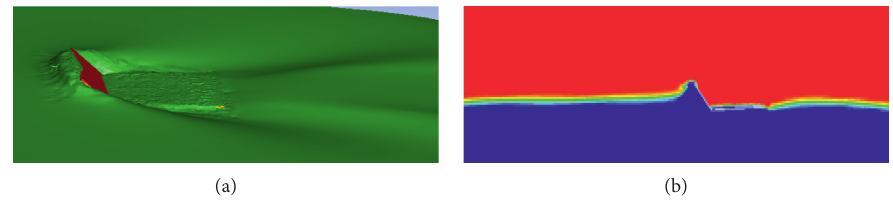
Figure 4: Simulation results of 50 ° floating plate. (a) 50 ° free waveform diagram. (b) 50 ° volume fraction diagram.